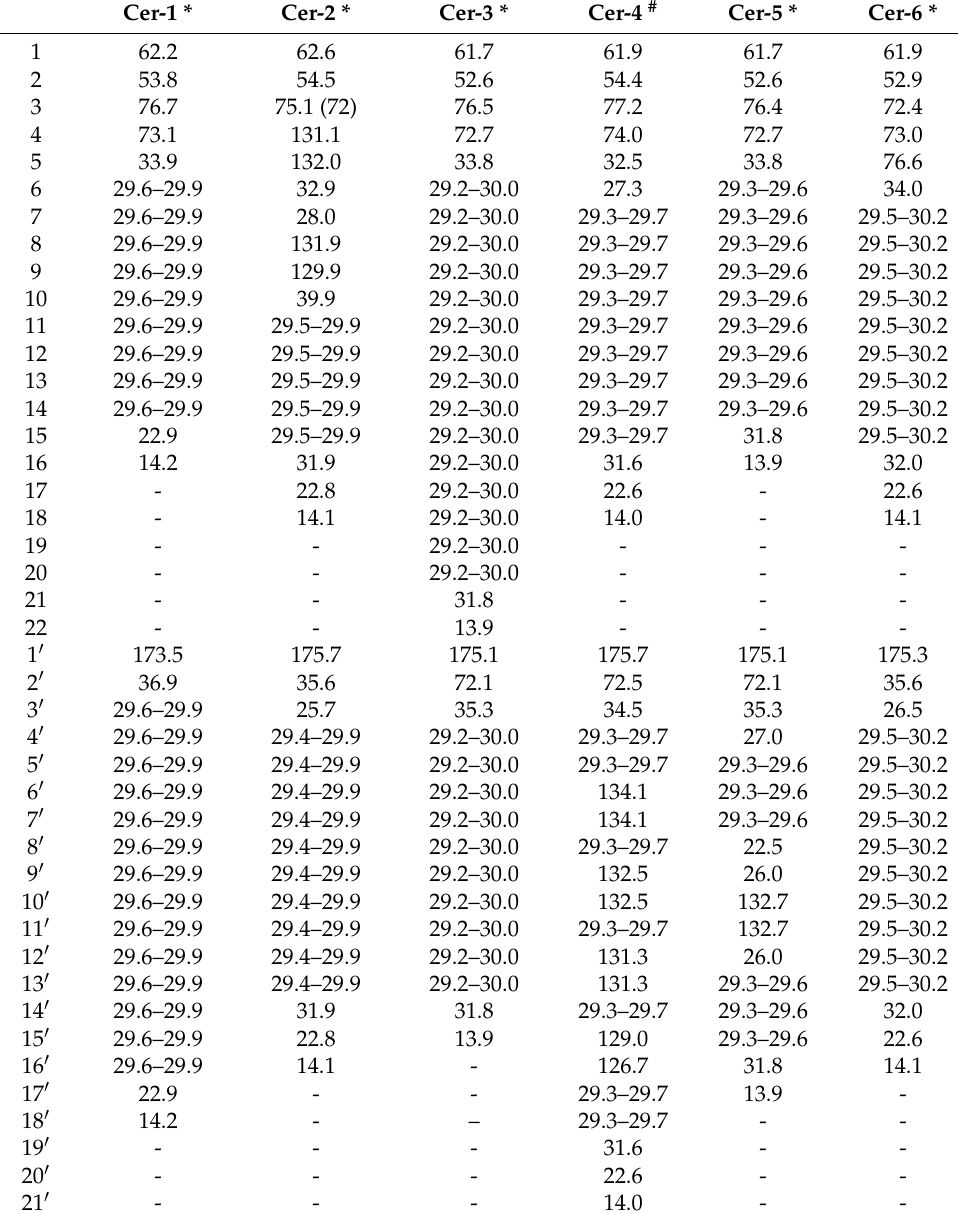
Table 3. 13 C NMR spectra of isolated compounds 1–6